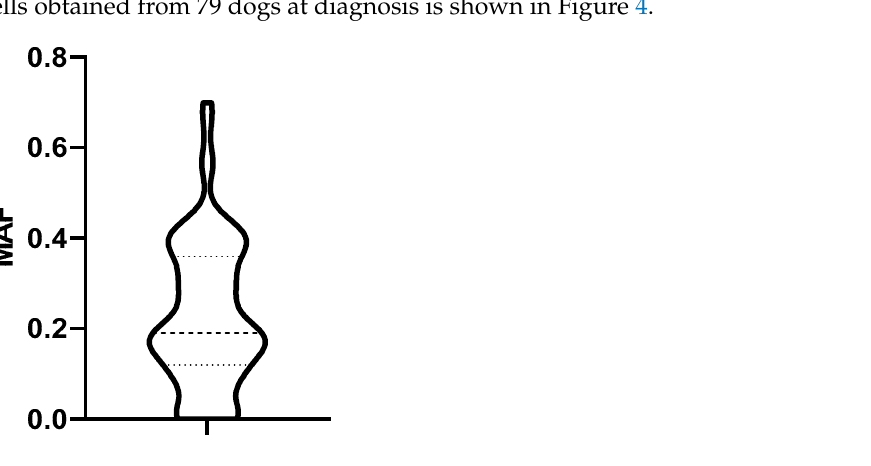
Figure 3. Results of the Calcein AM assay. Flow cytometry histogram showing the calcein fluorescence of tumor cells incubated in the presence (blue) or absence (purple) of verapamil, an inhibitor of the efflux pump (see Section 2). ( A ) Cells isolated from patient 5148–5570 show low P-gp activity. ( B ) Conversely, cells isolated from patient 9865–10,531 show lower fluorescence, which was restored by the P-gp inhibitor verapamil.